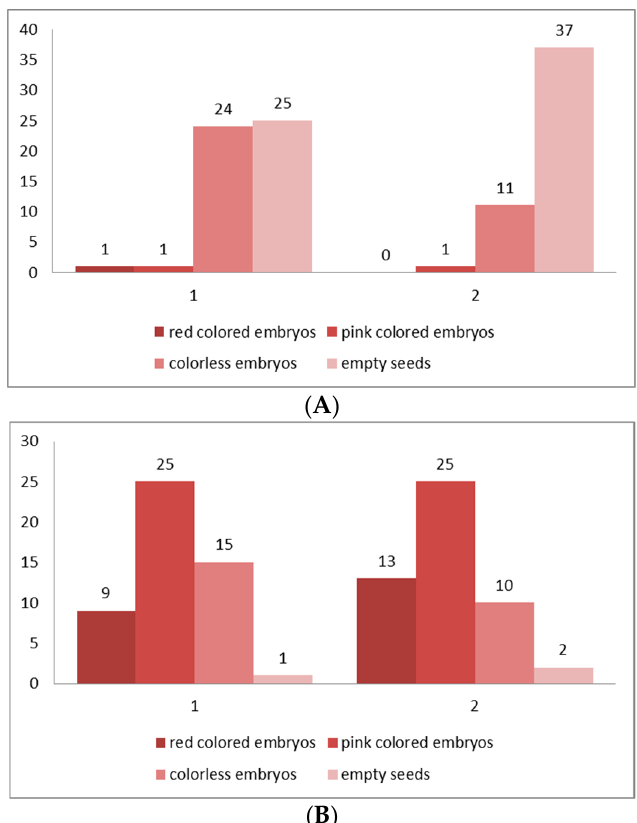
Figure 7. ( A , B ) Classification of the embryos viability in four classes according to the intensity of their staining after the results of TZ testing. ( A ) From seeds collected from the natural populations ( in situ ), ( B ) from seeds collected from the plants at the experimental plots (ex situ). Class I—seeds with viable embryo; completely (100%) colored in dark red; Class II—seeds with viable embryo; colored in pink; Class III—seeds with colorless embryo, unviable; Class IV—empty seeds without embryo. 1— Golo Bardo Mt population; 2—the Ilindentsi village population.